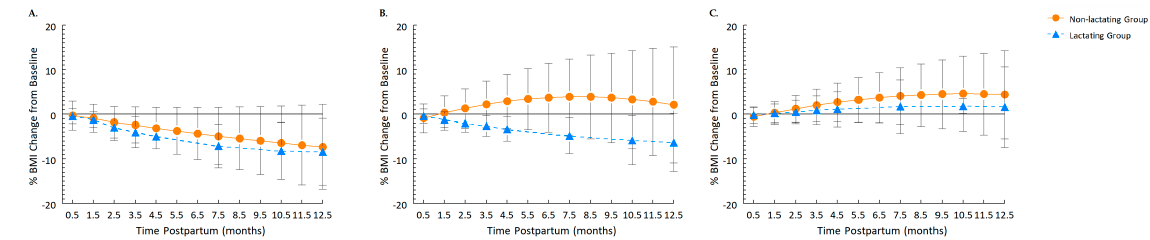
Figure 1. The trajectory of percent BMI change from baseline (0.5 month) to 1 year by infant feeding modality (Lactating group, Non-lactating group) for the ( A ) Prepregnancy Healthy Weight, ( B ) Prepregnancy Overweight, or ( C ) Prepregnancy Obesity group ( n = 206 total). The linear and quadratic coefficients of the BMI trajectories from the linear mixed-effect models revealed that in both the Prepregnancy Healthy Weight and Prepregnancy Overweight groups, non-lactating women significantly differed from lactating women. The Prepregnancy Obesity group showed a tendency for the linear coefficient of the trajectories to differ between non-lactating and lactating women, but there was no significant difference in the quadratic